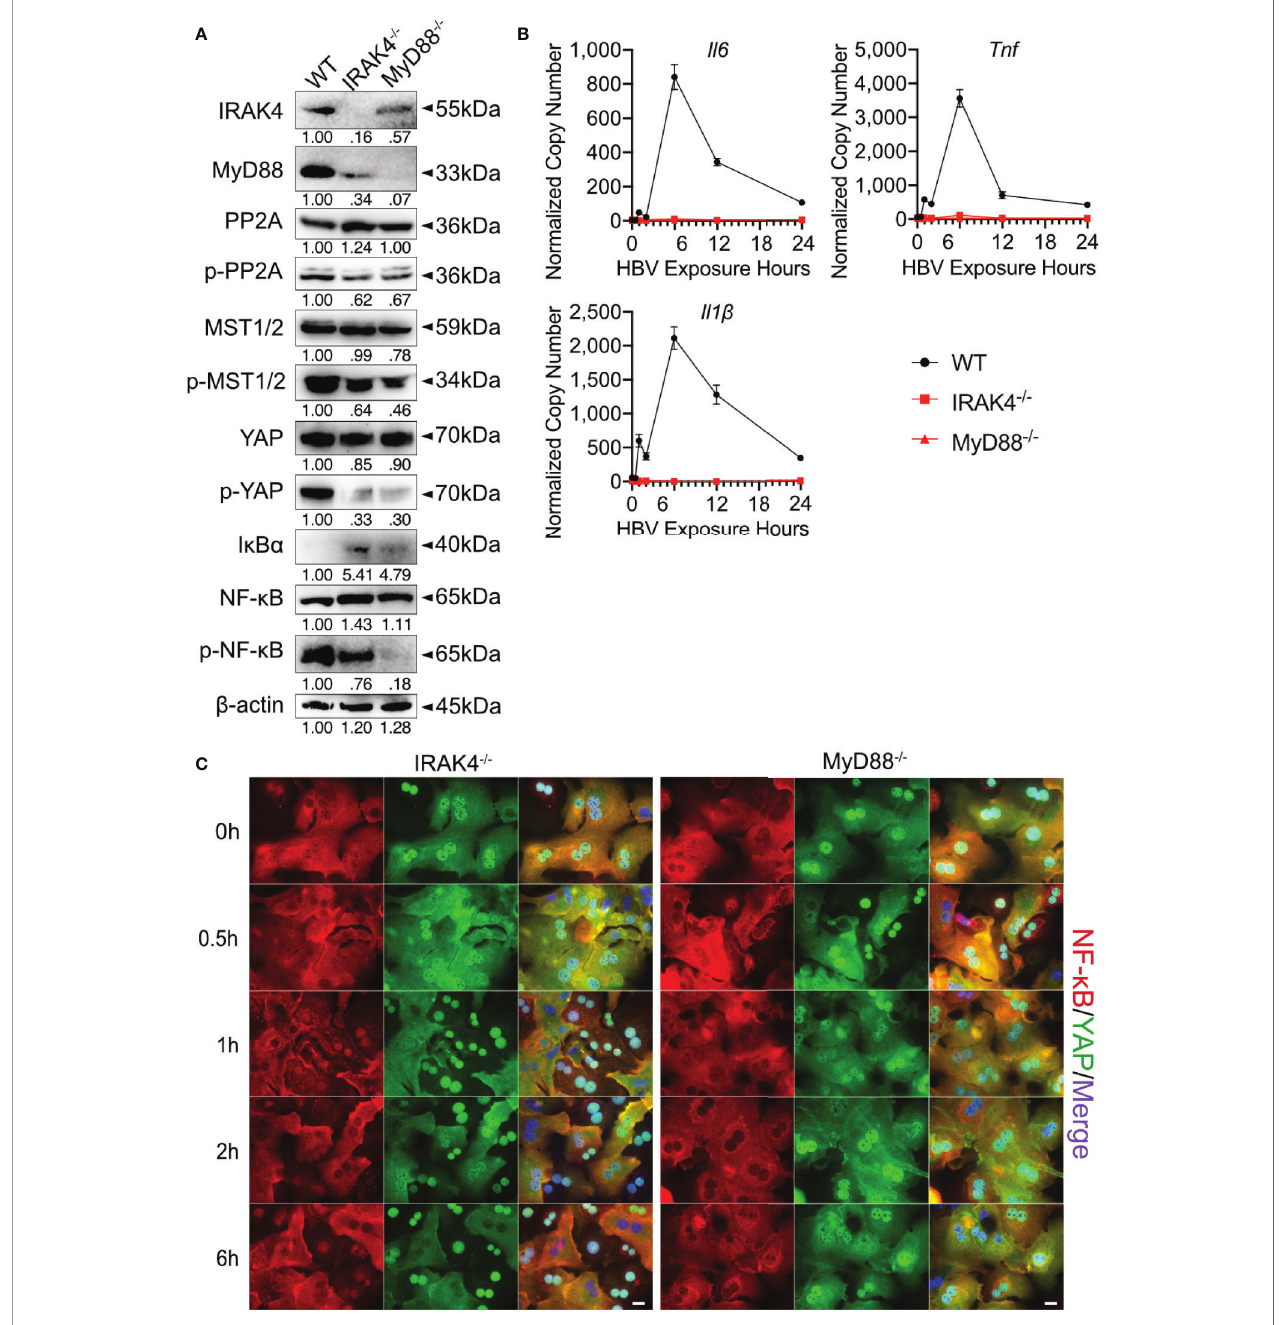
FIGURE 7 | MyD88 and IRAK4 continuously activate MST1/2 by phosphorylating and inducing the degradation of PP2A. Western blotting was performed to detect the abundance of IRAK4, MyD88, PP2A, phosphorylated PP2A, MST1/2, phosphorylated MST1/2, YAP, phosphorylated YAP, I k B a , NF- k B and phosphorylated NF- k B in PMHs derived from wild-type (WT), Irak4 -/- and Myd88 -/- male mice, representatively. Gel images were obtained with ADVANCED Fluorescence and ECL Imager, n=3 (A) . Quantitative PCR was performed to detect Il6 , Tnf and Il1 b expression at different time points after the exposure of PMHs isolated from WT, Irak4 -/- and Myd88 -/- mice to HBV at an MOI of 1,000 (B) , (normalized to Actb , mean ± SEM, n=3). Representative ICC staining was performed and obtained with Zeiss AxioObserver.Z1 and Apotome (40x objective) to visualize the intracellular localization of YAP (green) and NF- k B (red) in PMHs derived from Irak4 -/- and Myd88 -/- mice after HBV exposure. Raw images were subsequently proceeded with Image J software, N=3 independent experiments (C) . Scale bar, 20µm; kDa,